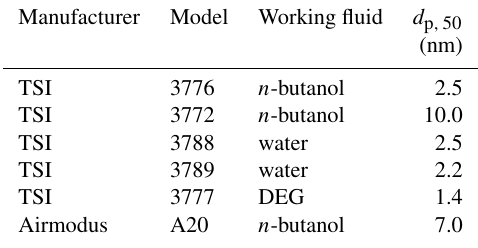
Table 1. Instrumentation used: the table shows the particle counters used, including their model numbers, the working fluids used and the 50% cutoff diameter as stated by the